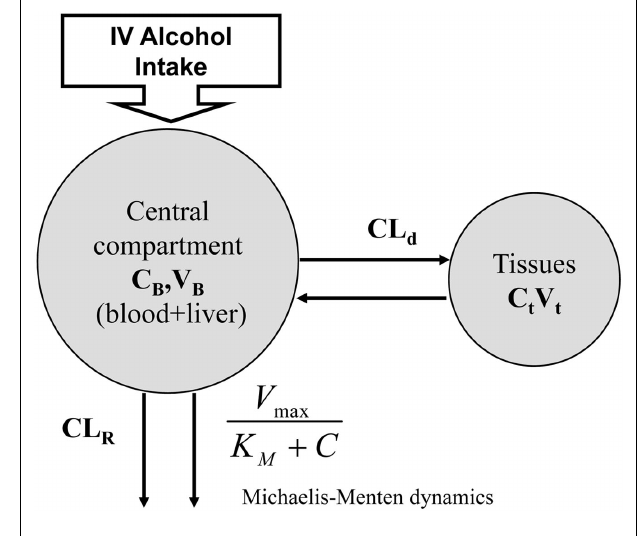
FIGURE 4 | Norberg’s alcohol clearance model featuring Michaelis–Menten dynamics. Suitable for description of intravenous (IV) ethanol